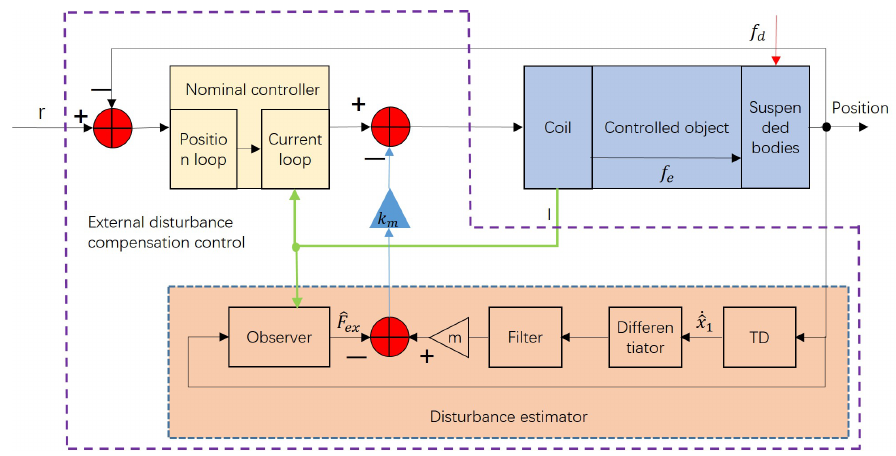
Figure 6. The disturbance force compensation framework of the